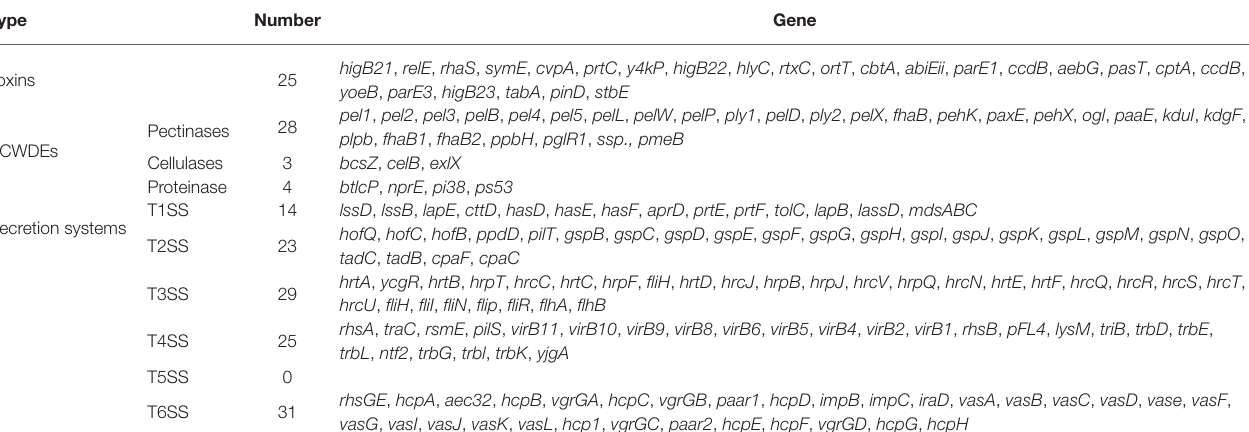
TABLE 3 | Pathogenic candidate genes of P. aroidearum L6 identified through gene annotation screening.